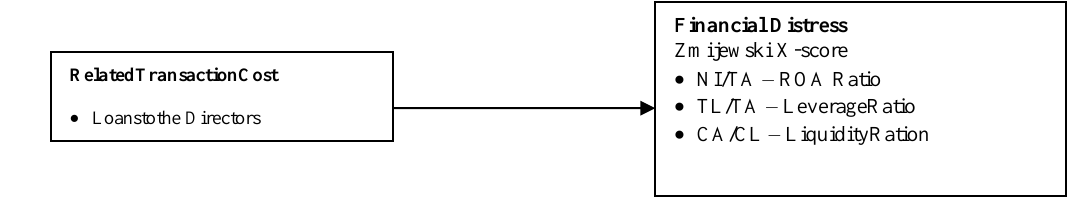
Figure 1: Conceptual